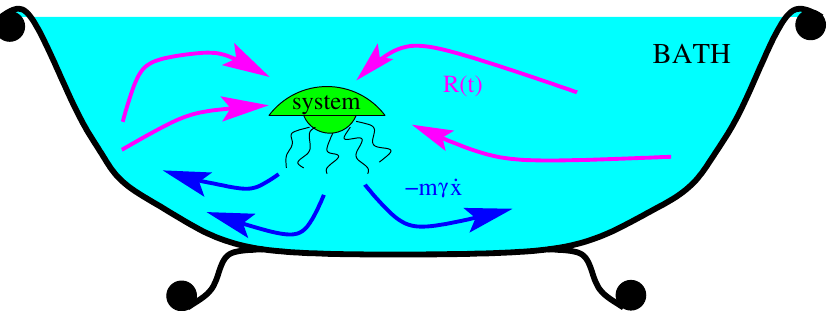
Figure 1. The Langevin Equations (4) and (5) as a thermal bath in classical molecular dynamics simulations: the random force R ( t ) (magenta arrows) pumps energy from the bath into the system, while the friction force − m γ ˙ x (blue arrows) extracts energy from the system. The balance between the two produces the correct thermal equilibrium. These forces can be modified to generate generalized baths with different given